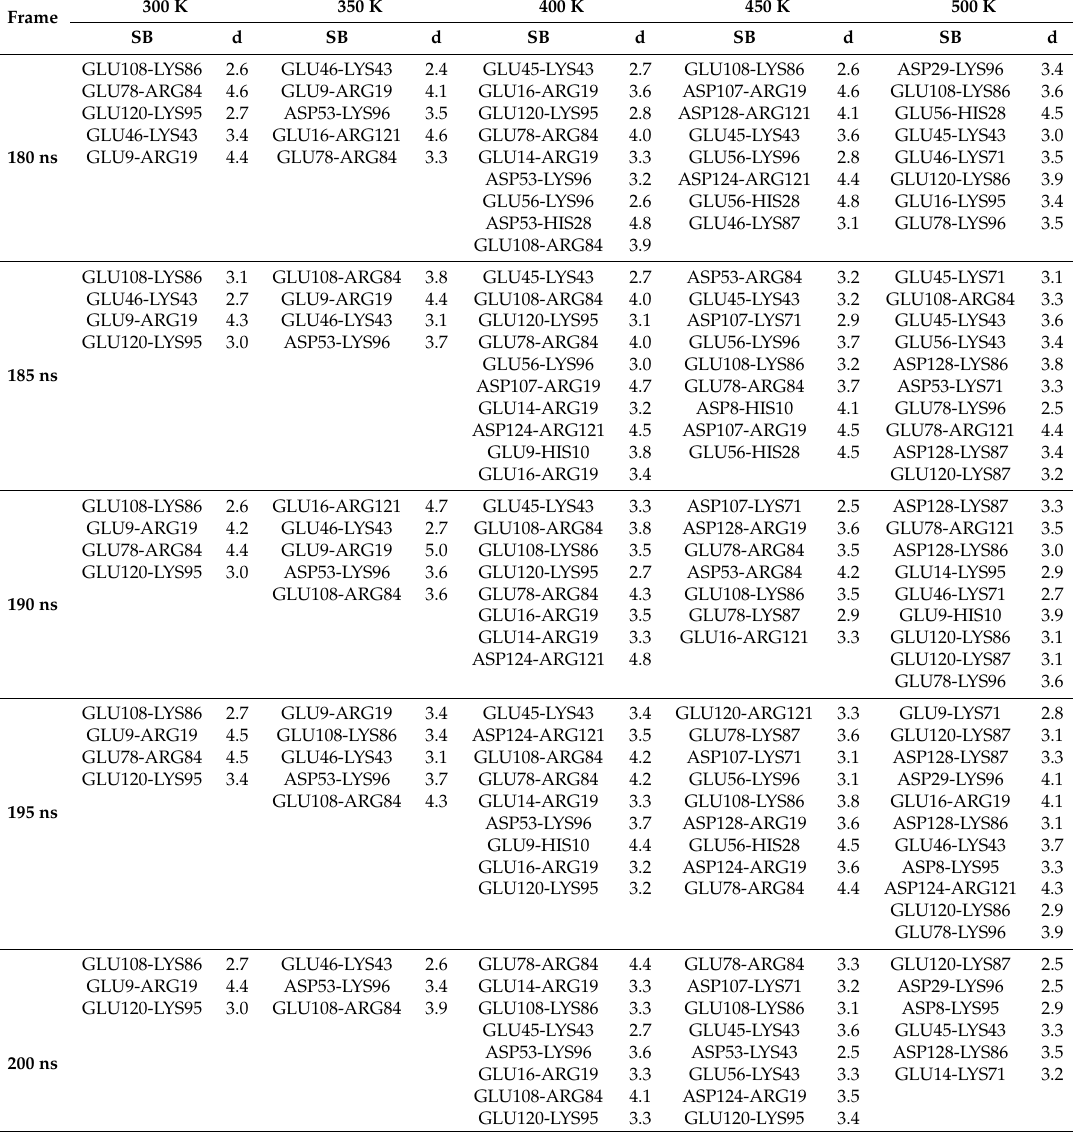
Table 2. Salt bridges (SB) analysis of each